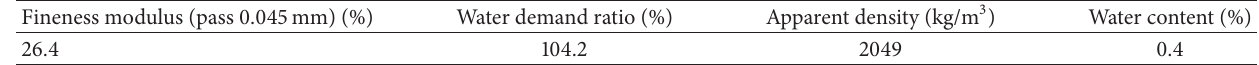
Table 2: Physical properties of fly ash.